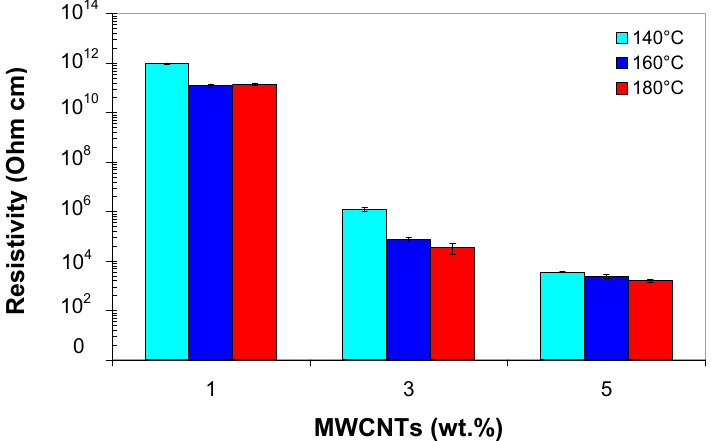
Figure 13. Electrical resistivity of EVA / MWCNT composite as a function of melt temperatures and MWCNT wt.% at 70 MPa injection pressure.